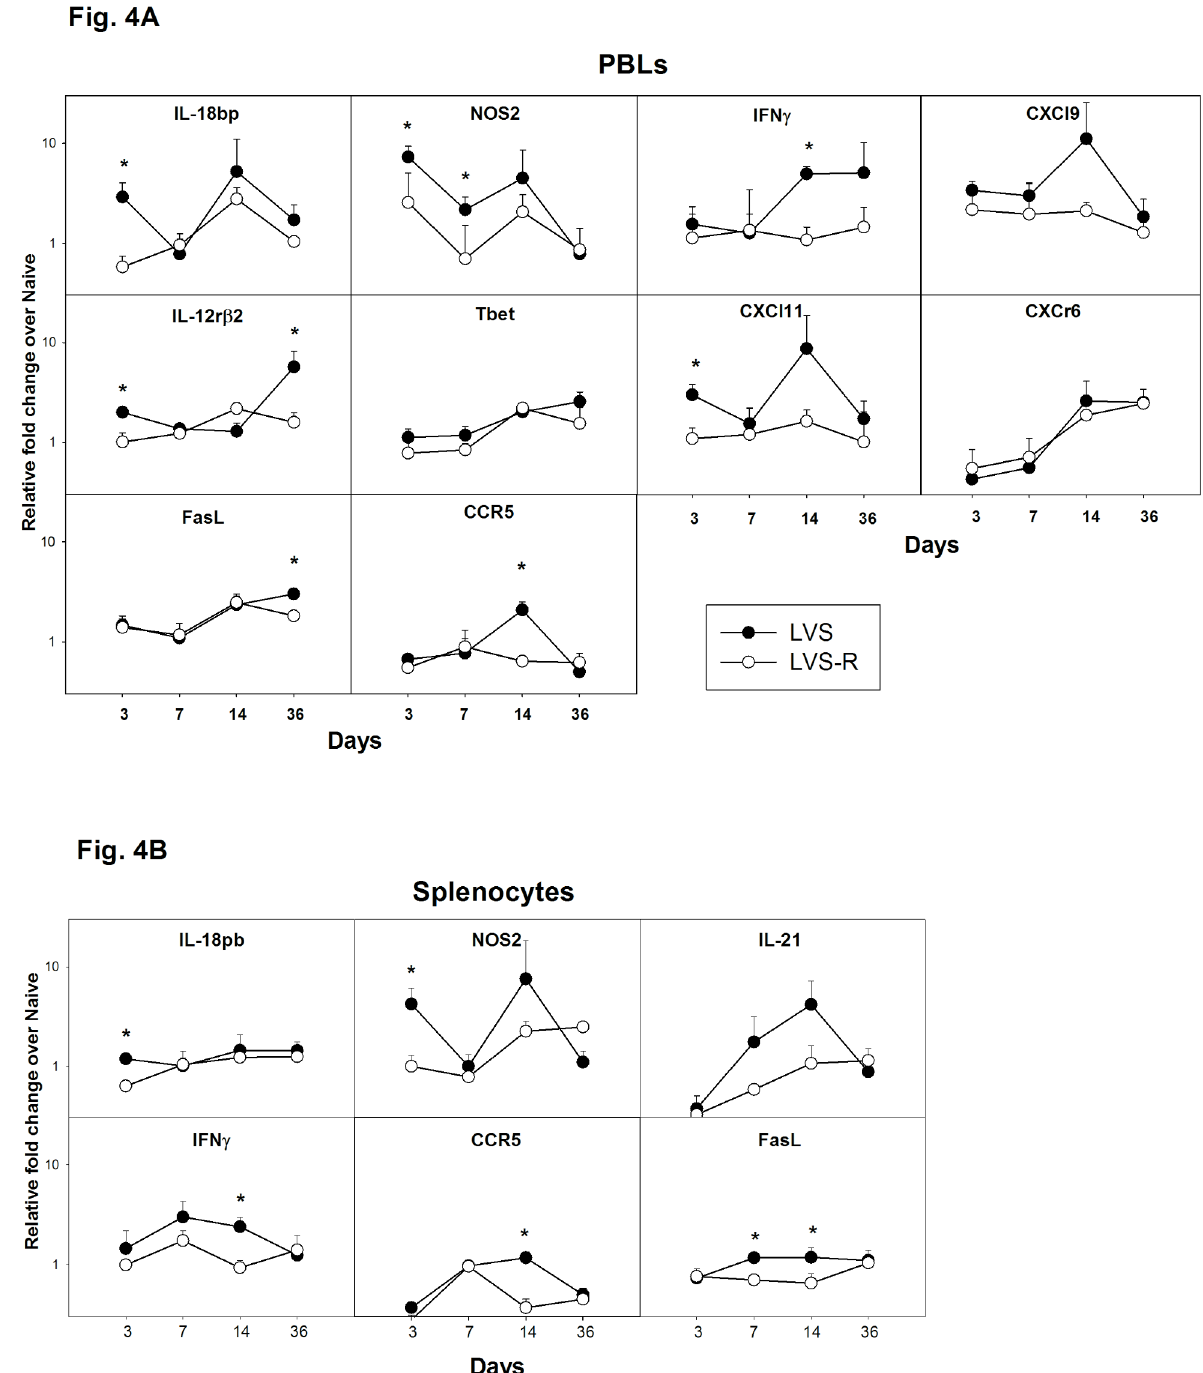
Fig 4. Gene expression of potential correlates of protection is differentially up-regulated in rat PBLs and splenocytes after vaccination with LVS-derived vaccines. Total RNA was purified from PBLs (Panel A) or splenocytes (Panel B) obtained at the indicated time points after vaccination from three naïve rats or from three rats immunized with LVS or LVS-R. RNA was used for semi-quantitative analyses of gene expression using the indicated sets of primers/probes. Values shown are average fold changes ± standard deviation of the indicated genes compared to those from naïve rats. Asterisks indicate significant differences in gene expression ( P < 0.05) between LVS- and LVS-R-derived cells.